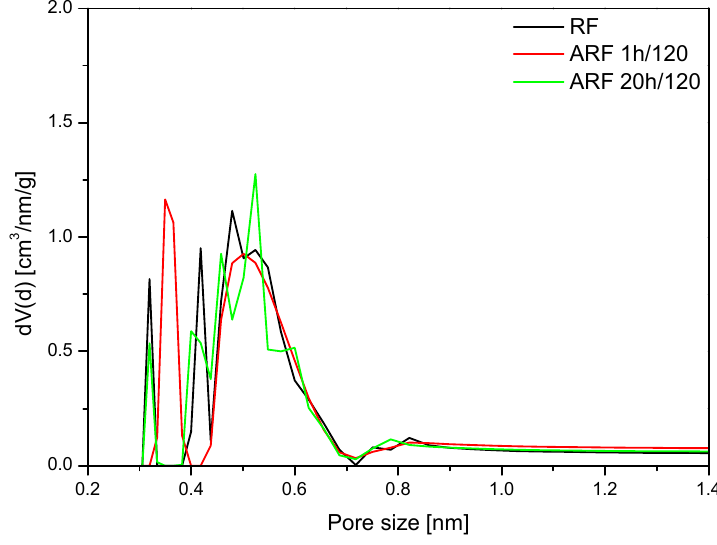
Figure 7. Pore size distributions of the unmodified samples.